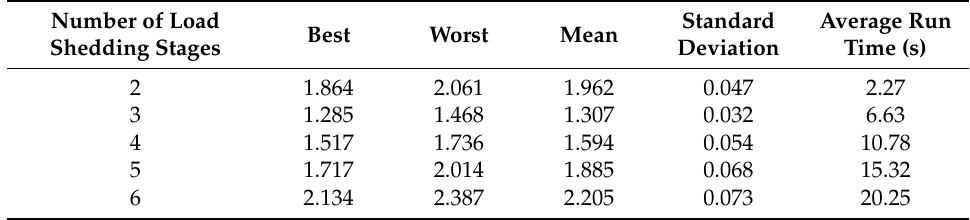
Table 5. Optimized UFLS schemes.